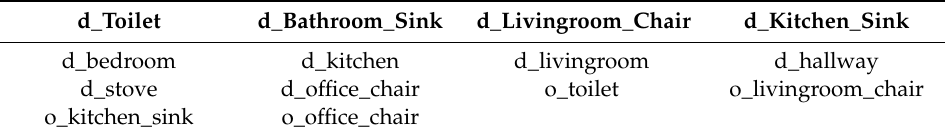
Table 2. Set of features guiding smart home movement